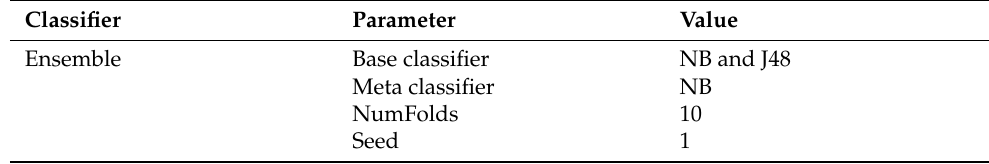
Table 6. The proposed ensemble models optimal